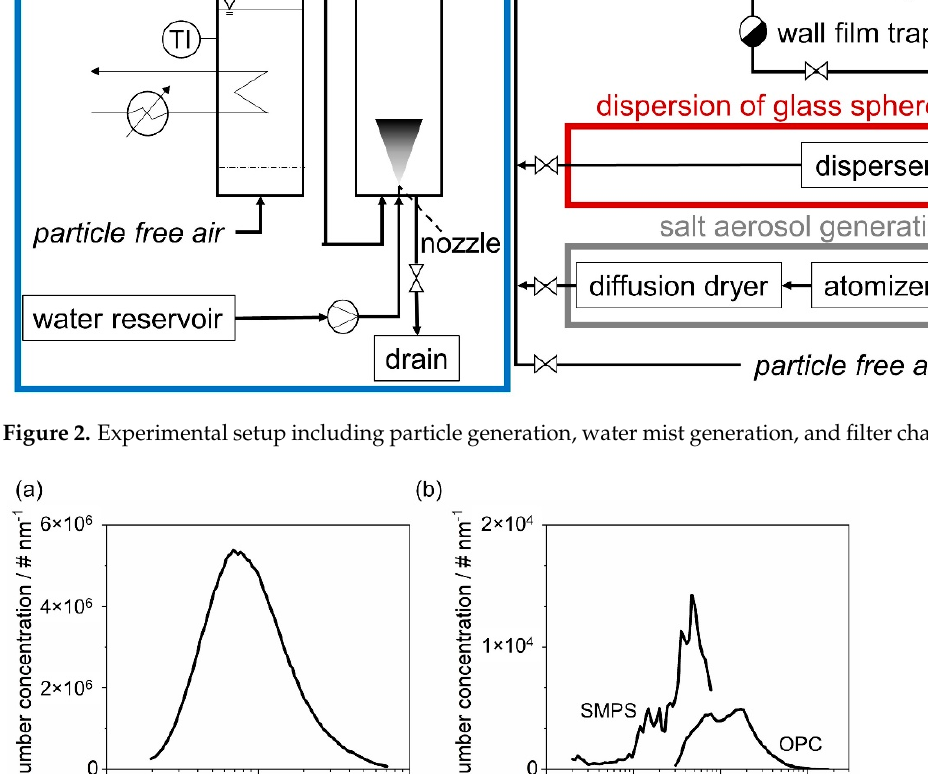
Figure 2. Experimental setup including particle generation, water mist generation, and filter cham- ber.